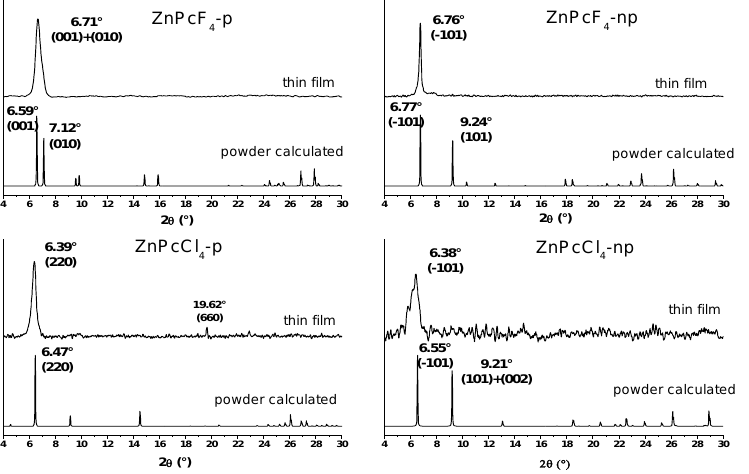
Figure 4. X-ray diffraction patterns of ZnPcHal 4 thin film in comparison with the calculated powder XRD patterns.